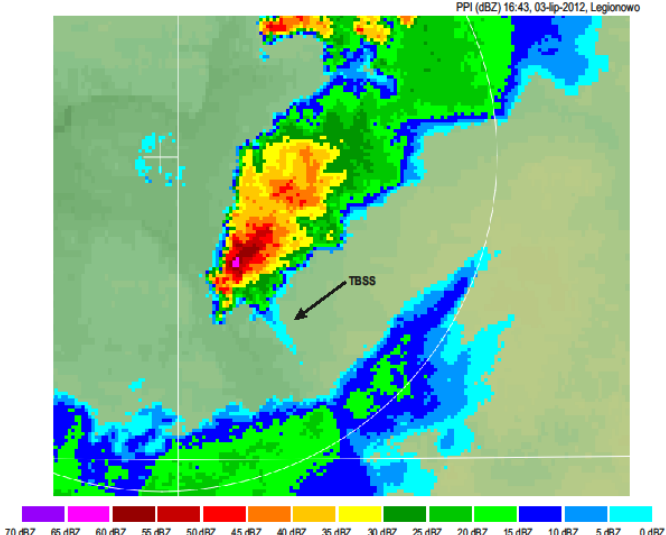
Fig. 8. PPI (10⁰ antenna tilt) of the supercell storm in eastern part of Warsaw. TBSS signature is visible at the back side of the storm (according to the radar location). July 3 rd , 2012, radar Legionowo